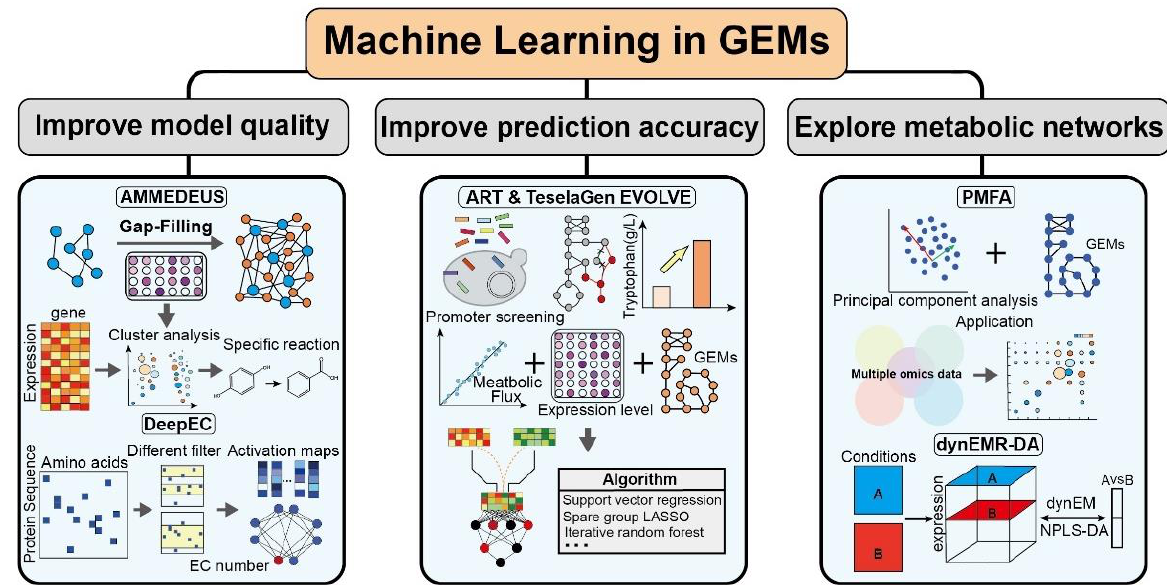
Figure 3. Representative application of machine learning in GEMs.